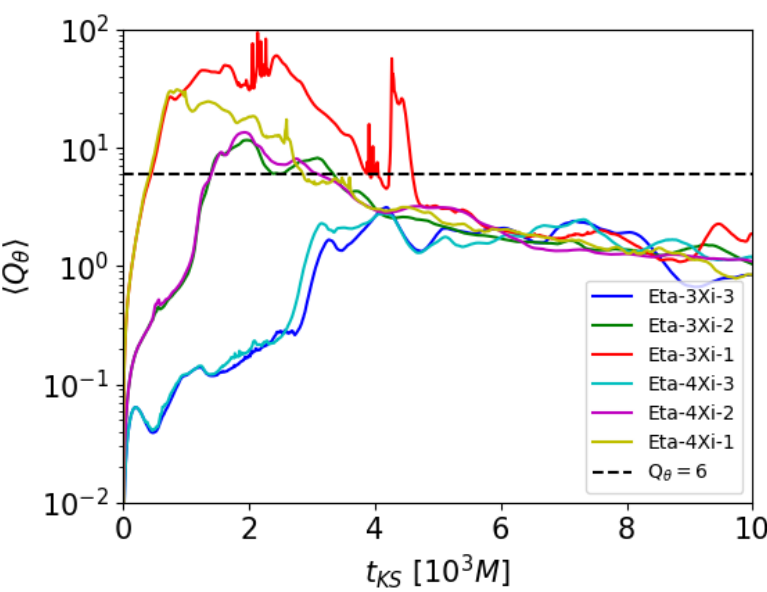
Figure 4. Time evolution of the Q θ quality factor averaged on the disk for each model. The dashed black line indicates the minimum threshold for solving the linear